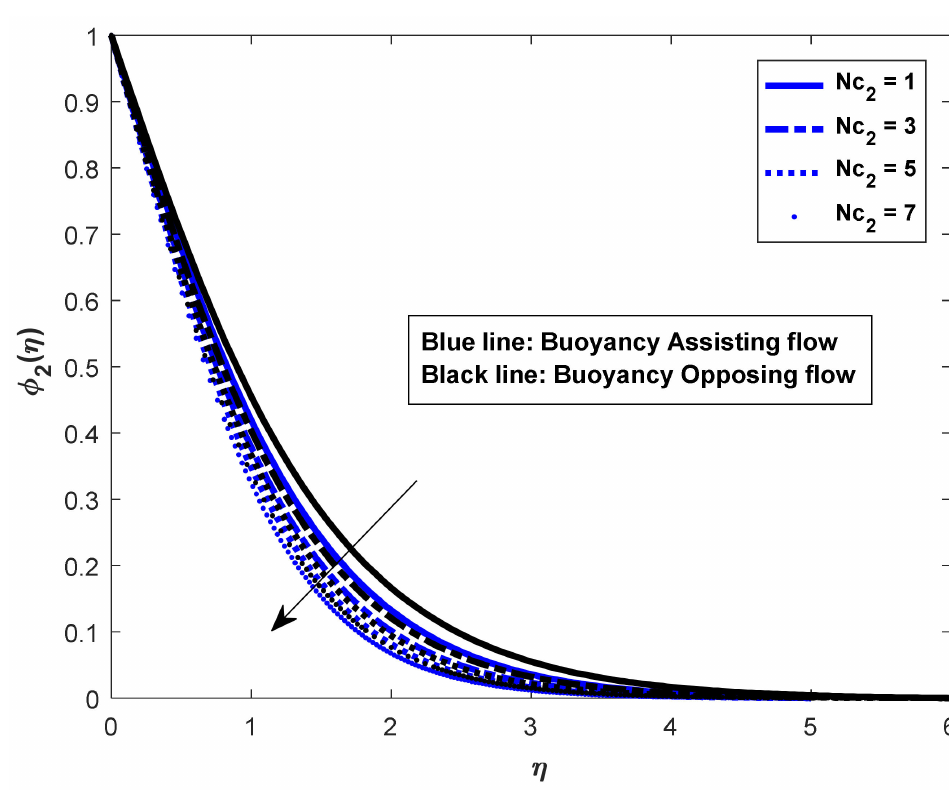
Figure 16. Nc 2 on salt_2